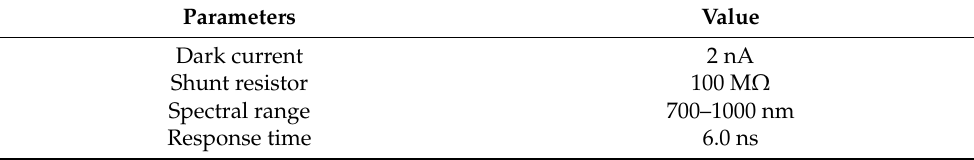
Table 1. Ocean Optics PixelSensor Photodiode performance parameters.